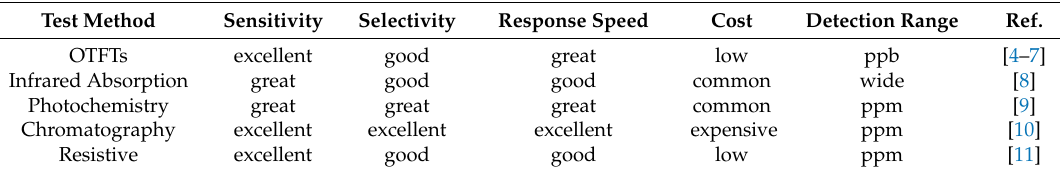
Table 1. Properties of some common used gas